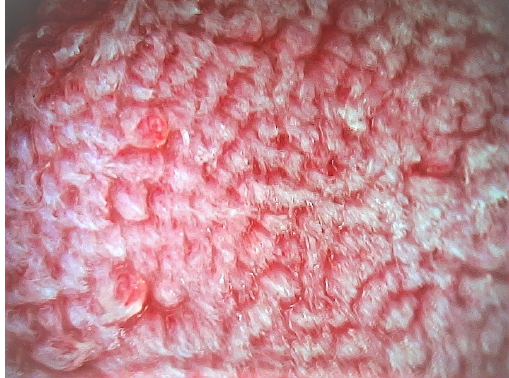
Figure 5. Dermoscopic image from dorsum of the tongue adjacent to the lesion showing normal pattern of fungiform lingual papillae in contrast to the blunting of papillae seen in Figure 4. (Escope Videodermoscope, 20×, polarized mode).